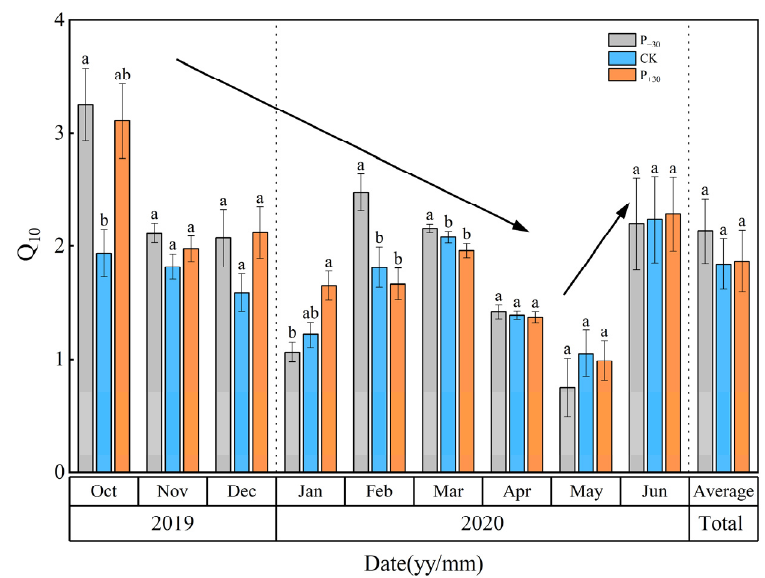
Figure 7. Monthly average dynamics of temperature sensitivity (Q 10 ) in three precipitation treatments during the winter wheat whole growth period. Vertical bars represent standard errors of the mean. Different letters represent significant differences ( p < 0.05) among the three precipitation treatments in the same month. Three precipitation treatments containing the same letter in the same month indicate nonsignificant differences ( p > 0.05).